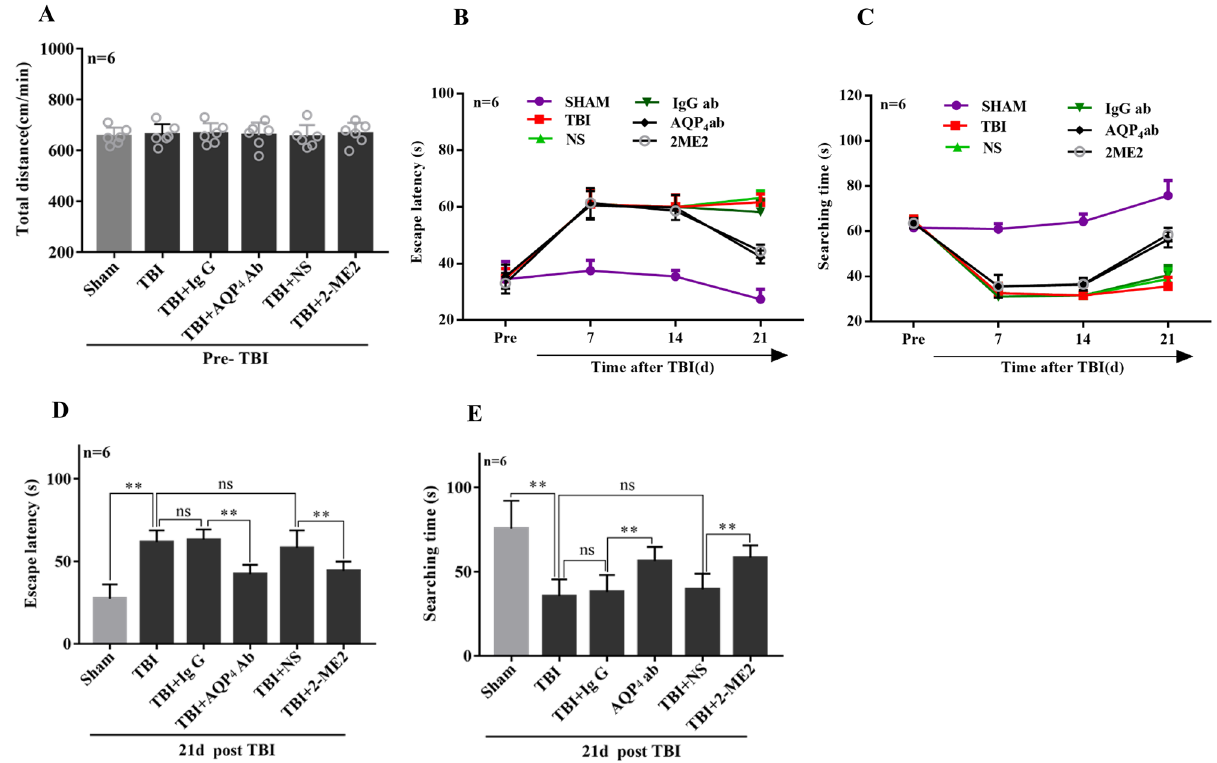
Figure 3. Early post-traumatic inhibition of AQP4 and HIF-1α markedly alleviated TBI-induced neurological functional deficits in long term learning and memory. In the water maze test, rats were placed in a large circular pool filled with opaque water and were given the task to swim to a platform that can be either visible or hidden. ( A ) Before TBI, the swimming distance per minute of rats in each group showed no significant difference . TBI rats were intravenously injected via the tail vein with 0.25 ml isotonic saline containing AQP4 antibodies (1 μg/ kg of body weight) or 2-ME2 (2.5 mg/kg of body weight) within 30–60 min after impact, the corresponding controls were injected with IgG and isotonic saline, respectively. The Morris water maze tests were performed and the escape latency ( B ) and searching time ( C ) were investigated at the indicated time points, such as shown on the 21st day post-TBI in ( D , E ). Data represent mean ± SEM, n = 6 per group. The comparisons among groups were analyzed by one-way ANOVA with the LSD method. * P < 0.05, between the two groups. ns